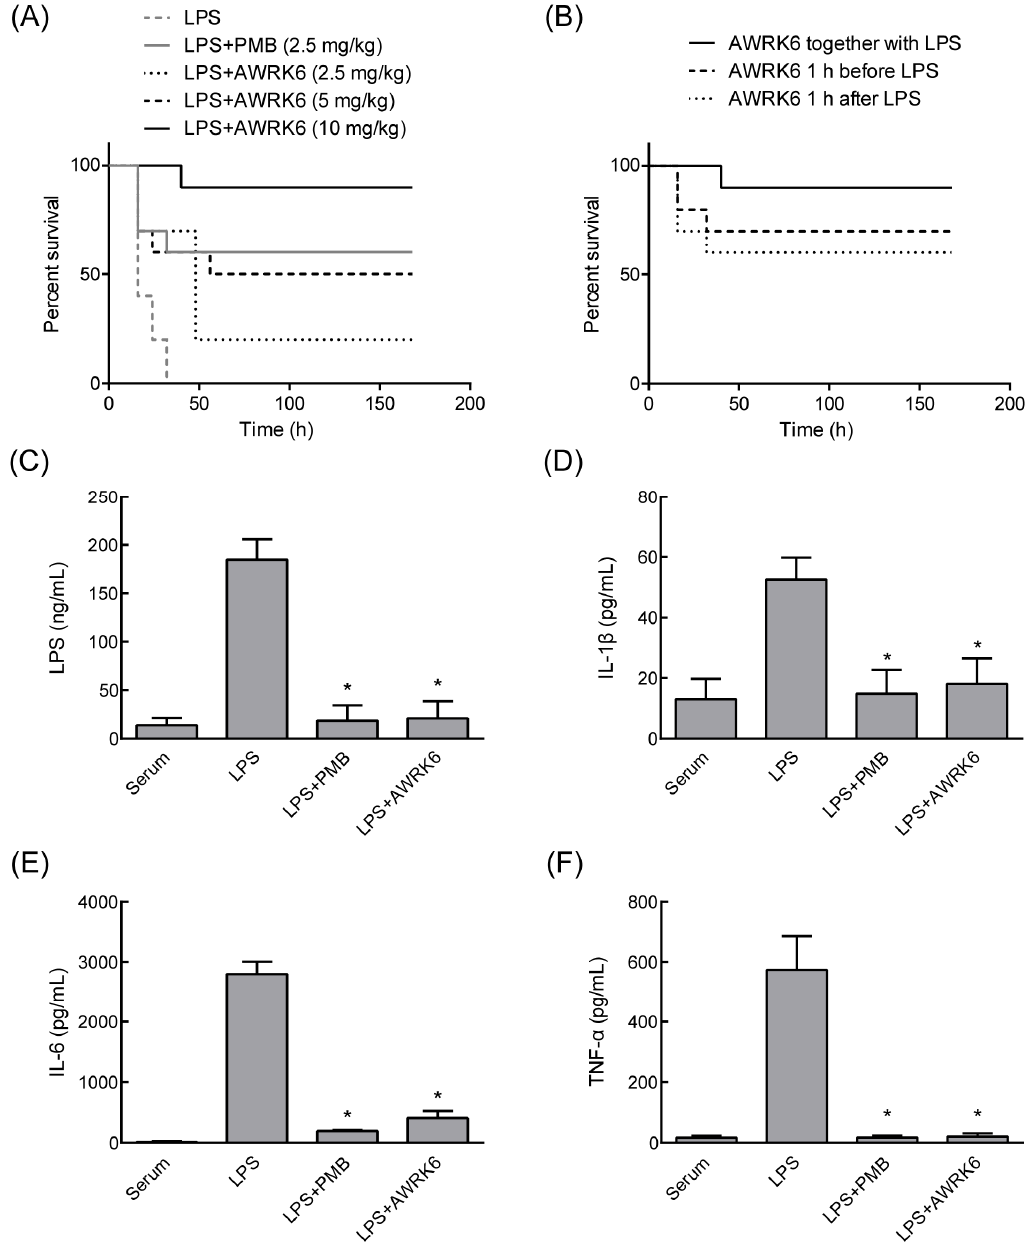
Figure 2. AWRK6 prevented LPS-induced lethal endotoxemia in mice. ( A ) The survival curves of LPS-induced endotoxemic mice treated with a single dose of AWRK6 (2.5, 5, or 10 mg/kg, n = 30). ( B ) The survival curves of endotoxemic mice treated with 10 mg/kg AWRK6 at different time points ( n = 30). ( C – F ) The effects of AWRK6 treatment (10 mg/kg) on the serum levels of LPS, IL-1 β , IL-6, and TNF- α in the endotoxemic mice. PMB was used as a positive control. * p < 0.05 compared with the LPS group.